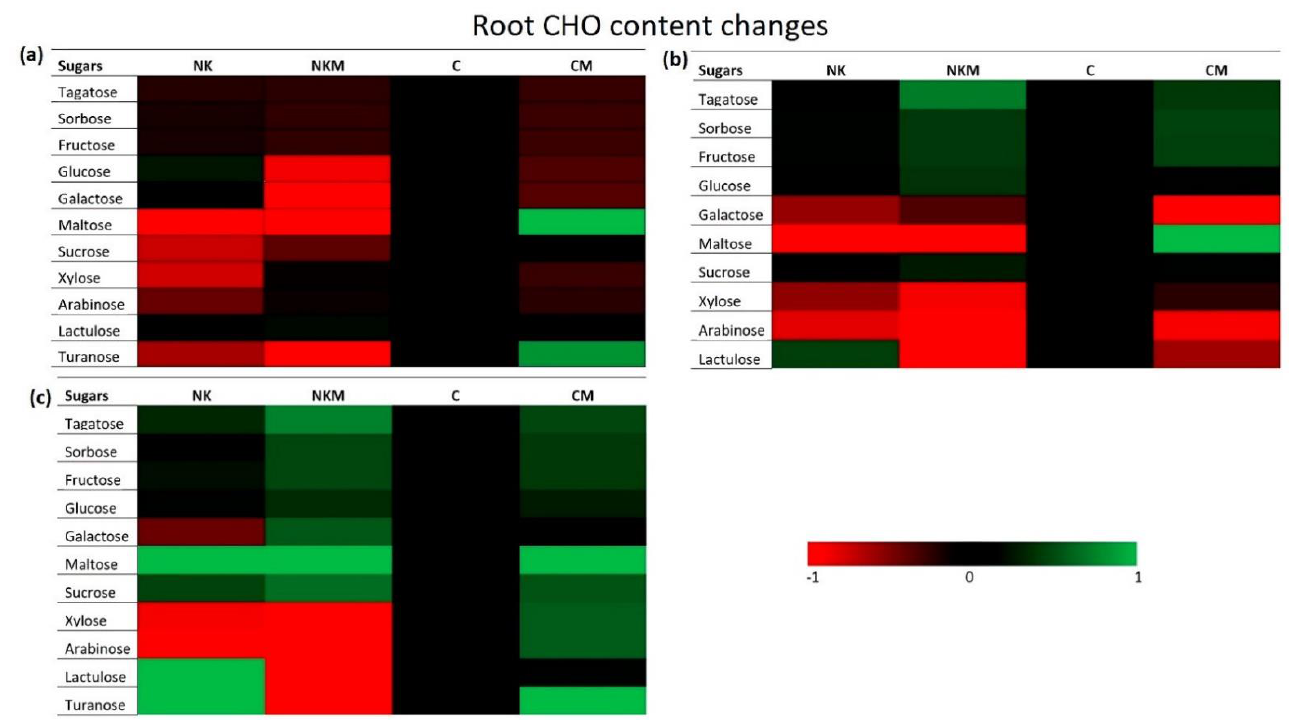
Figure 5. ( a – c ) Heatmap of root CHO content changes in all treatments (NK: KNO 3 fertilizer; NKM: KNO 3 in combination with PGPR; CM: NH 4 NO 3 fertilizer in combination with PGPR) in comparison with the control (C: NH 4 NO 3 fertilizer) in the first ( a ), second ( b ) and third ( c ) sampling periods. The green color indicates increased levels of metabolites, while the red color indicates decreased levels of metabolites. Amounts have been expressed as relative abundance based on the relative response compared to the internal standard (adonitol).